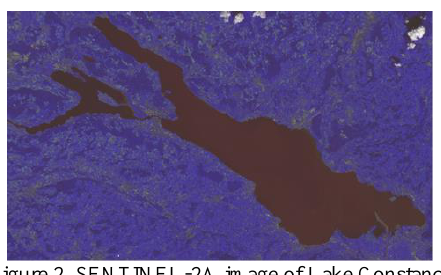
Figure 2. SENTINEL-2A image of Lake Constance